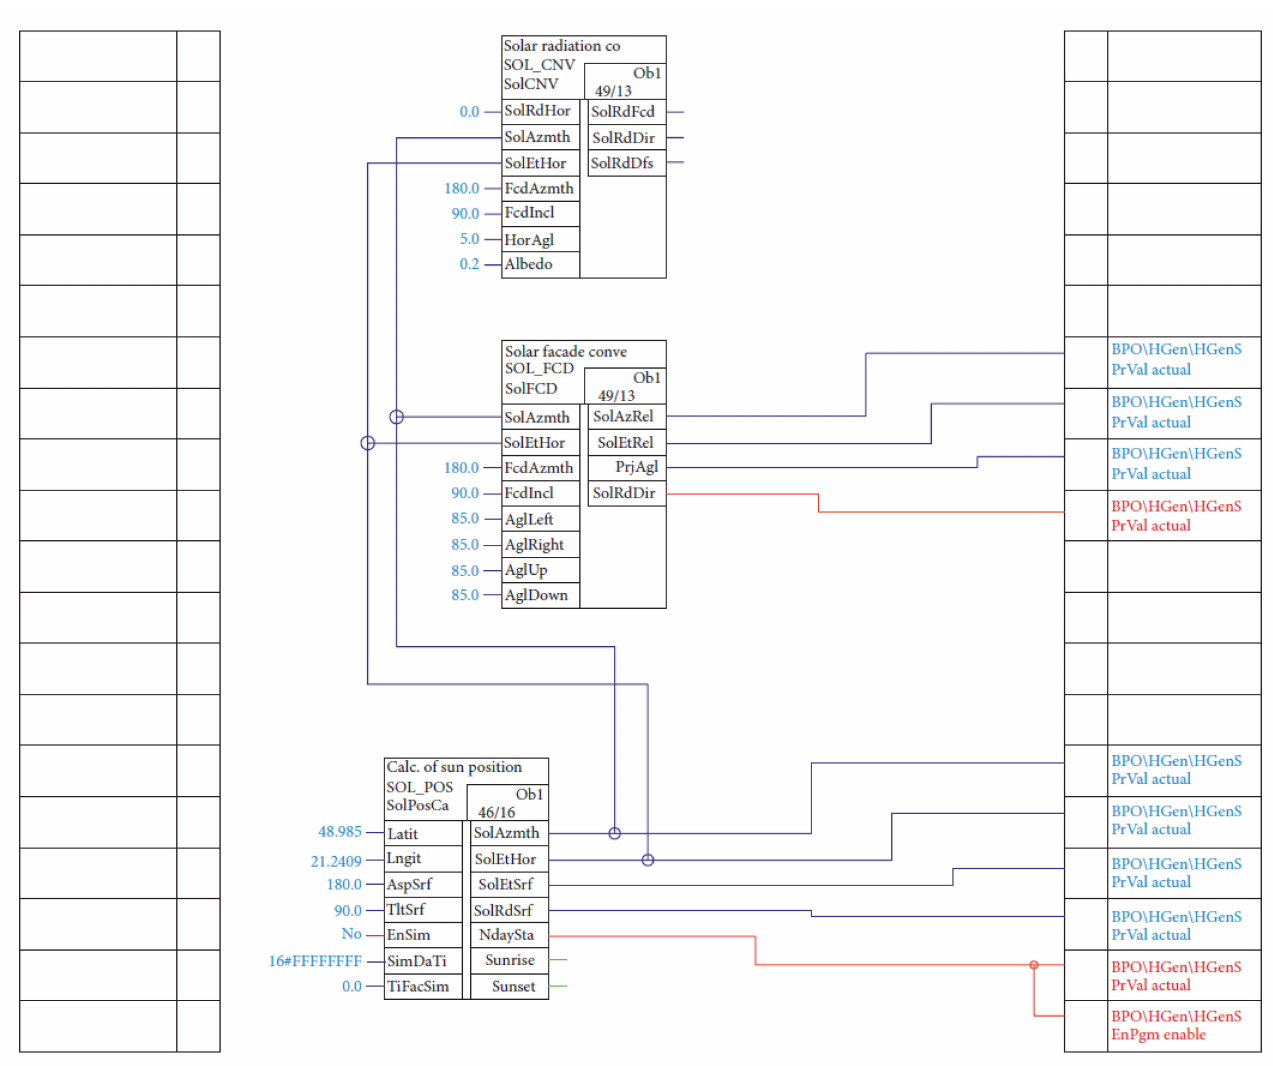
Figure 6. A block diagram of the Sun position